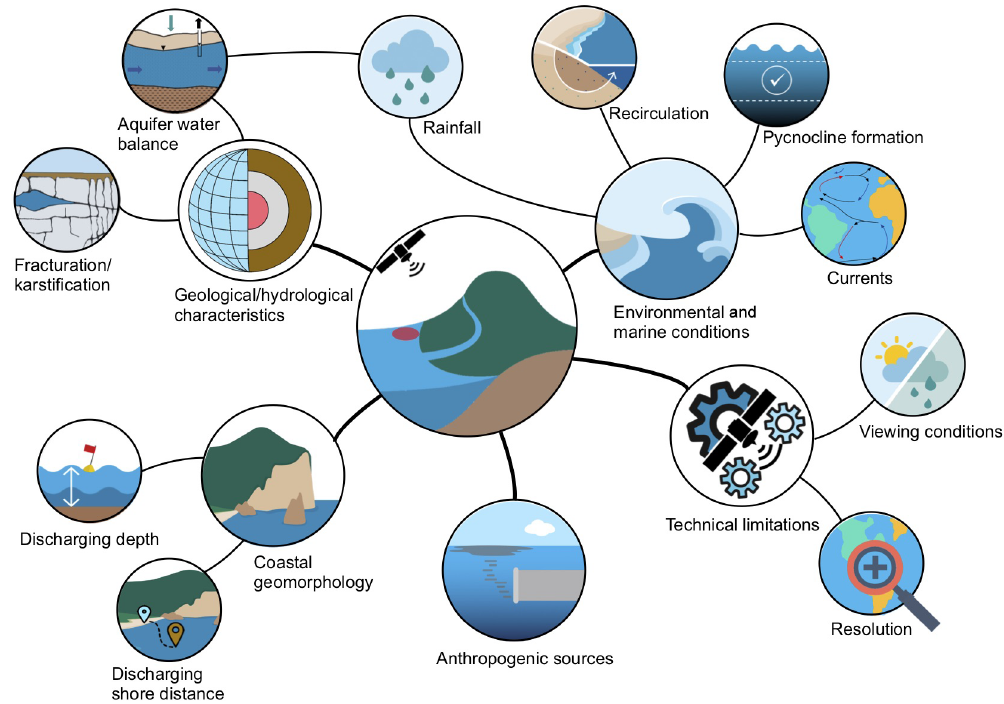
Figure 4. Conceptual framework of technical limitation factors that can limit the identification of SGD springs by using Landsat 8 TIRS